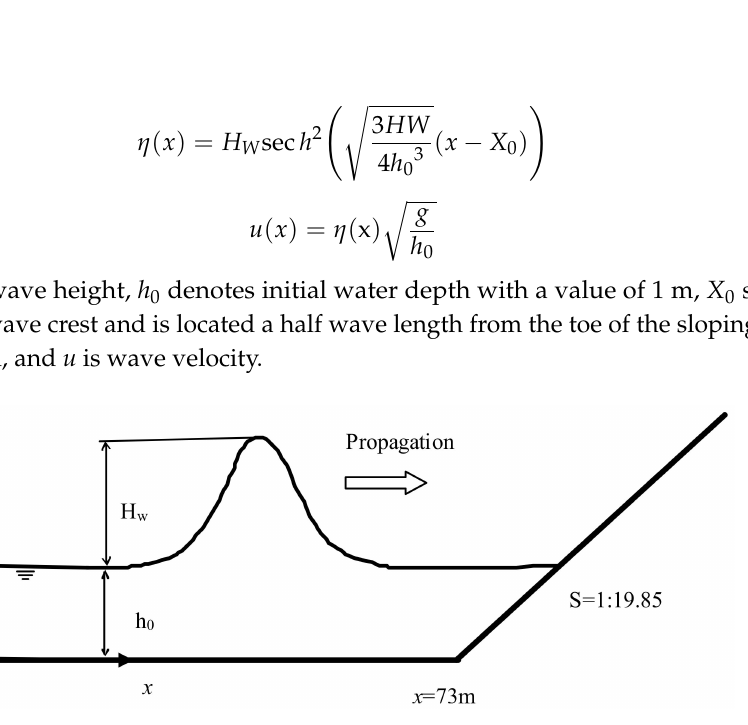
Figure 2. Sketch of the solitary wave propagation on a sloping